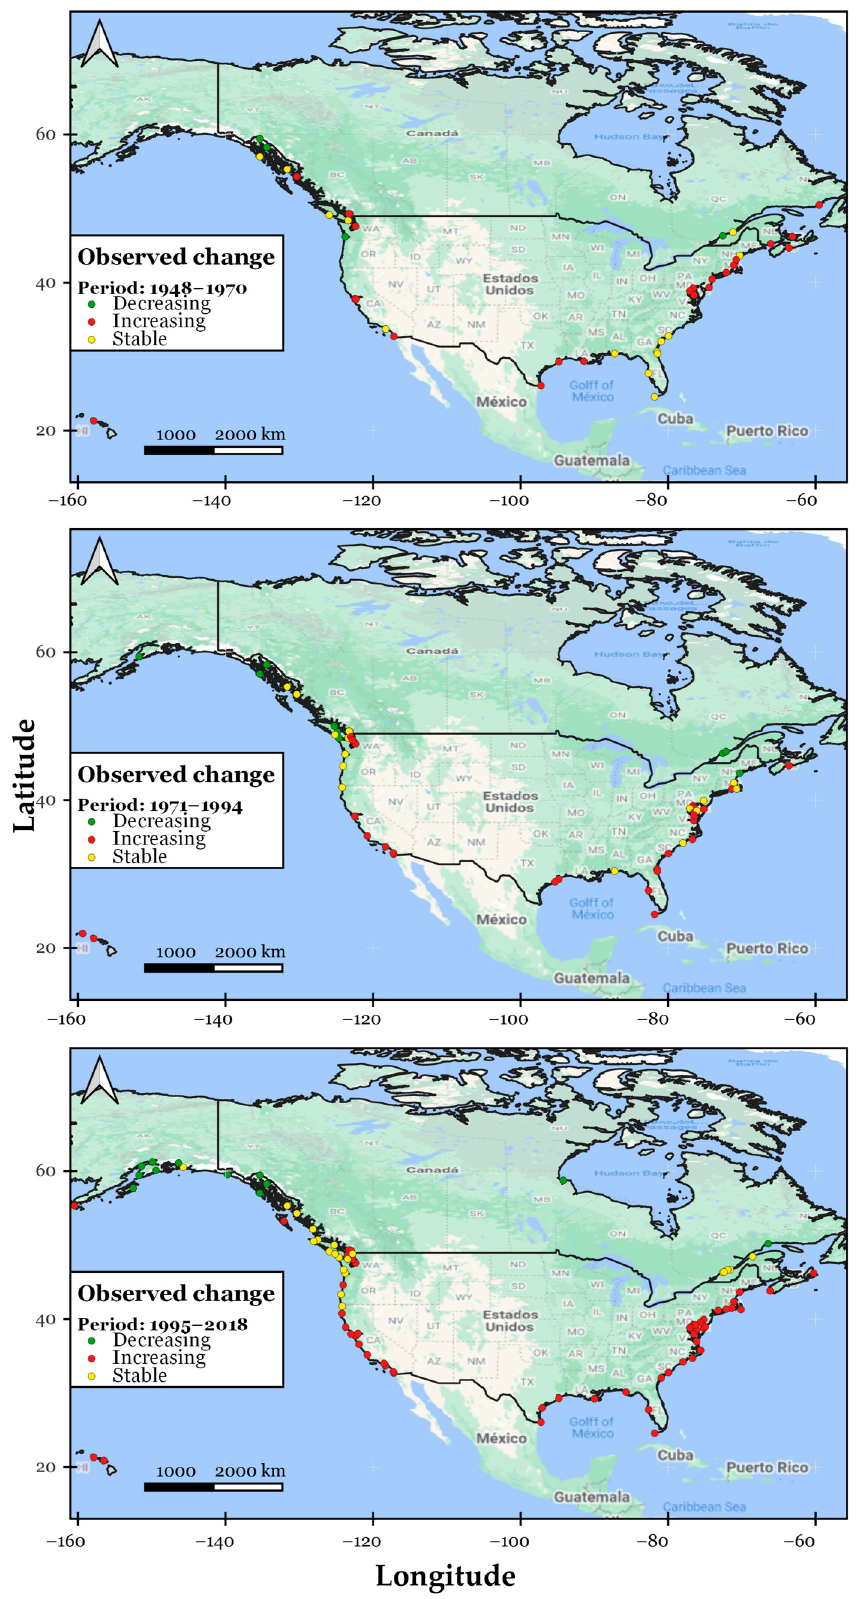
Figure 6. Spatial distribution of the trend in coastal sea levels using the modified MK test for the epochs: ( a ) 1948–1970, ( b ) 1971–1994, and ( c ) 1995–2018.